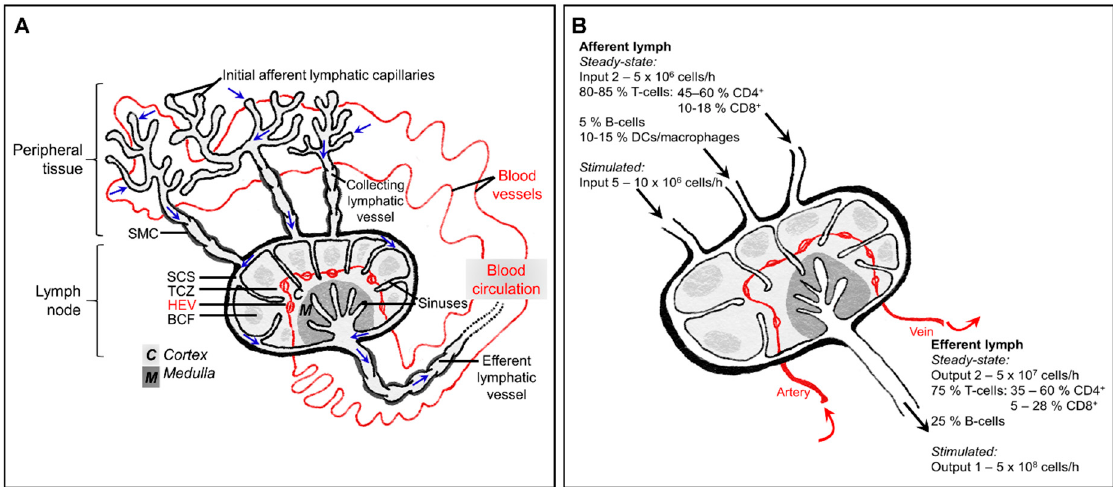
Figure 1. The interplay between the blood circulation and lymphatic system, and immune cell composition of afferent and efferent lymph. ( A ) In peripheral tissue, fluid and macromolecules that have leaked from the blood, as well as leukocytes, leave the interstitium and enter initial lymphatic capillaries. This lymph fluid (movement of which is indicated by blue arrows) then passes into larger collecting vessels which contain intraluminal valves and are invested with contracting smooth muscle cells (SMC), finally entering the lymph node at the subcapsular sinus (SCS). Fluid and low molecular weight particles (<70 kDa) percolate through the fibroblastic reticular network of the lymph node. Leukocytes cross the lymphatic endothelium into the lymph node parenchyma at subcapsular or medullary sinuses, or exit directly through the efferent lymphatic vessel. Lymphocytes enter the lymph node from the blood by way of high endothelial venules (HEV), then are guided by chemokines to areas of the lymph node, including the T-cell zone (TCZ) and B-cell follicle (BCF). Lymphocytes return to the blood circulation via the efferent lymphatic vessel and thoracic duct. ( B ) Distribution of leukocyte subsets in afferent and efferent lymph, from studies of ovine skin-draining lymph nodes. The cellularity of afferent lymph is much lower (5–10%) than that of efferent lymph under homeostatic conditions. Additionally, afferent lymph contains a more heterogeneous assortment of leukocytes, whereas only lymphocytes are found in efferent lymph.